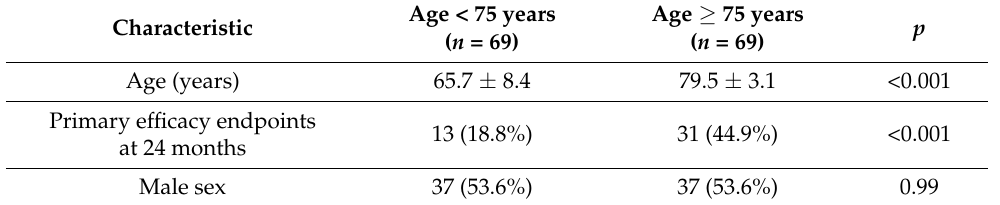
Table 3. Baseline characteristics and primary efficacy endpoint according to age after matching.